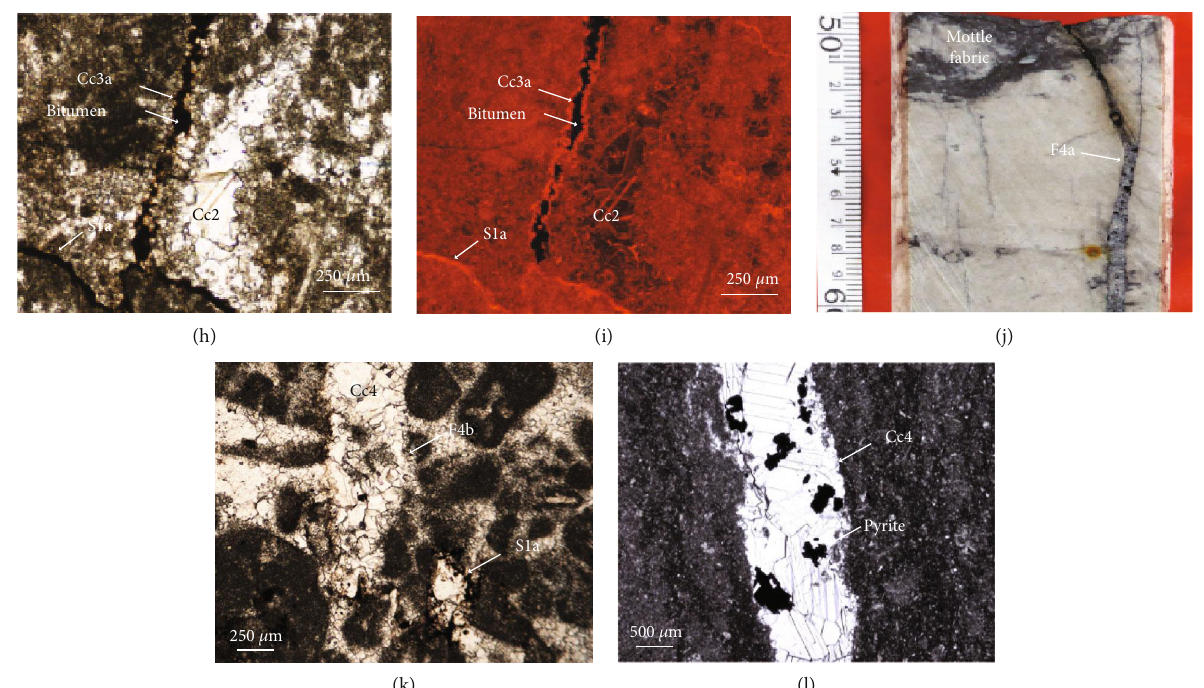
Figure 6: (a) Hand specimen of the Tumuxiuke Formation showing F1 fractures. (b) Plane light optical photomicrograph of palisade calcite (Cc1) and internal sediment (Cs1) in an F1 fracture. (c) Plane light optical photomicrograph of F2a fractures crosscutting calcite sediment Cs0a within rounded mottle fabrics. (d) Plane light optical photomicrograph showing a F2b fracture crosscutting a F2a fracture. (e) Optical-CL photomicrograph showing Cc2 calcite in fi lling F2 fractures and V2 vugs. (f) Hand specimen of the Tumuxiuke Formation showing F3 fractures. F3 fractures cross-cut rounded mottle fabrics. (g) Panchromatic SEM-CL image showing Cc3a calcite crystals that are zoned in SEM-CL. Bitumen fi lls remaining void space in the center of the fracture. (h, i) Cc2 and Cc3a calcite cements under (h) plane light and (i) optical-CL. (j) Hand sample specimen showing F4a fractures. (k) Plane light optical photomicrograph showing F4b fractures fi lled with blocky calcite (Cc4). (l) Plane light optical photomicrograph showing F4a fractures fi lled with blocky calcite (Cc4) and concurrent